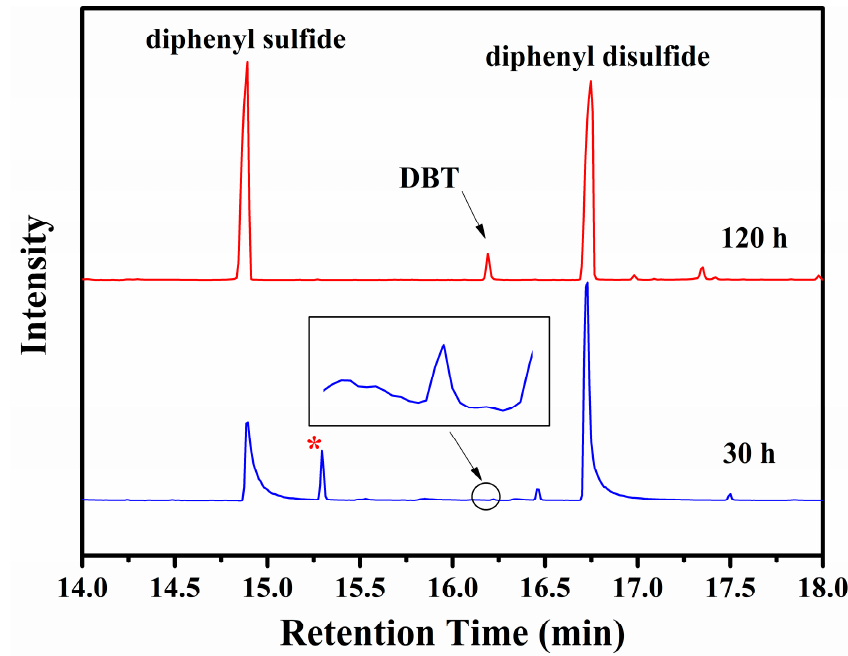
Figure 8. GC of samples thermally treated at 220–225 °C. *: silicon-containing contaminant from column.